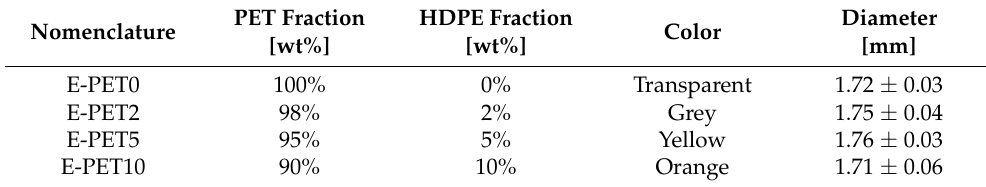
Table 1. Characteristics of the extruded